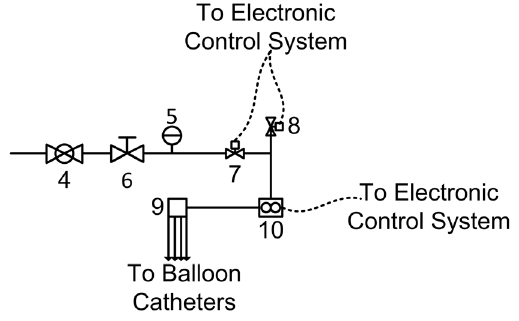
Figure 2. Pneumatic subsystem schematic: main pressure valve (4), pressure dial (5), pressure regulator (6), pressurizing solenoid valve (7), venting solenoid valve (8), pressure manifold (9), and air flow meter (10). Solid lines indicate pneumatic connections. Dashed lines indicate electrical connections (see Figure